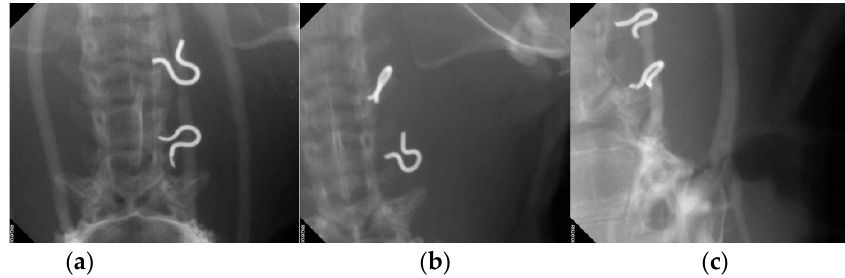
Figure 4. Repair of the artificial carotid artery defect: ( a ) direct closure of the artery defect as control group; patch angioplasty with ( b ) PTFE patch, and ( c ) 4-HR silk patch.